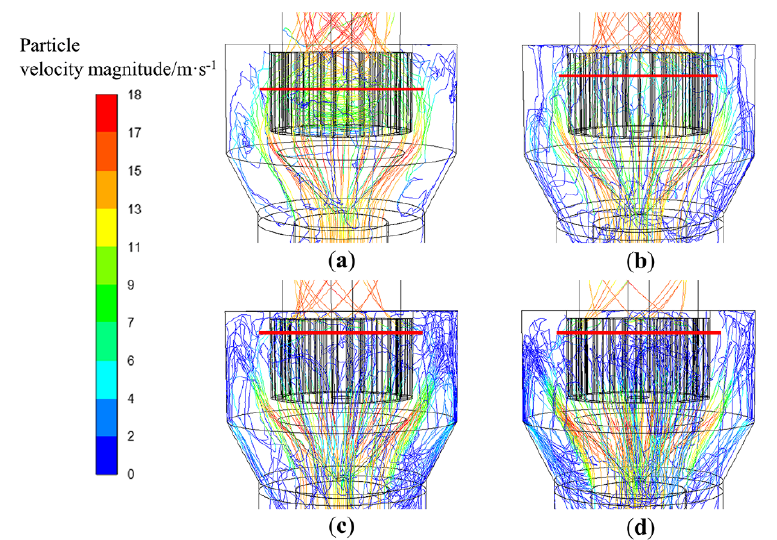
Figure 8. Trajectories of different size particles in T-A (1-1) : ( a ) d = 5 μ m, ( b ) d = 15 μ m, ( c ) d = 25 μ m, and ( d ) d = 35 μ m.